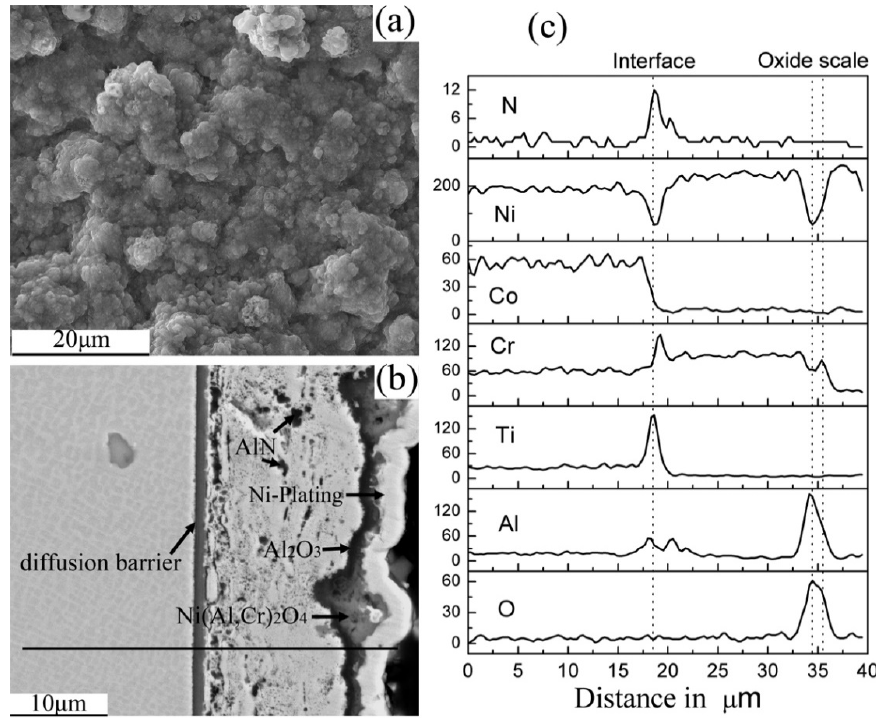
Figure 8. Surface SEM image ( a ), Cross-sectional BSE image ( b ) and the element depth profiles (( c ), analyzed by EDX) of K417/TiN/Ni+CrAlYSiN coating system after oxidation for 100 h at 1000 °C in air.